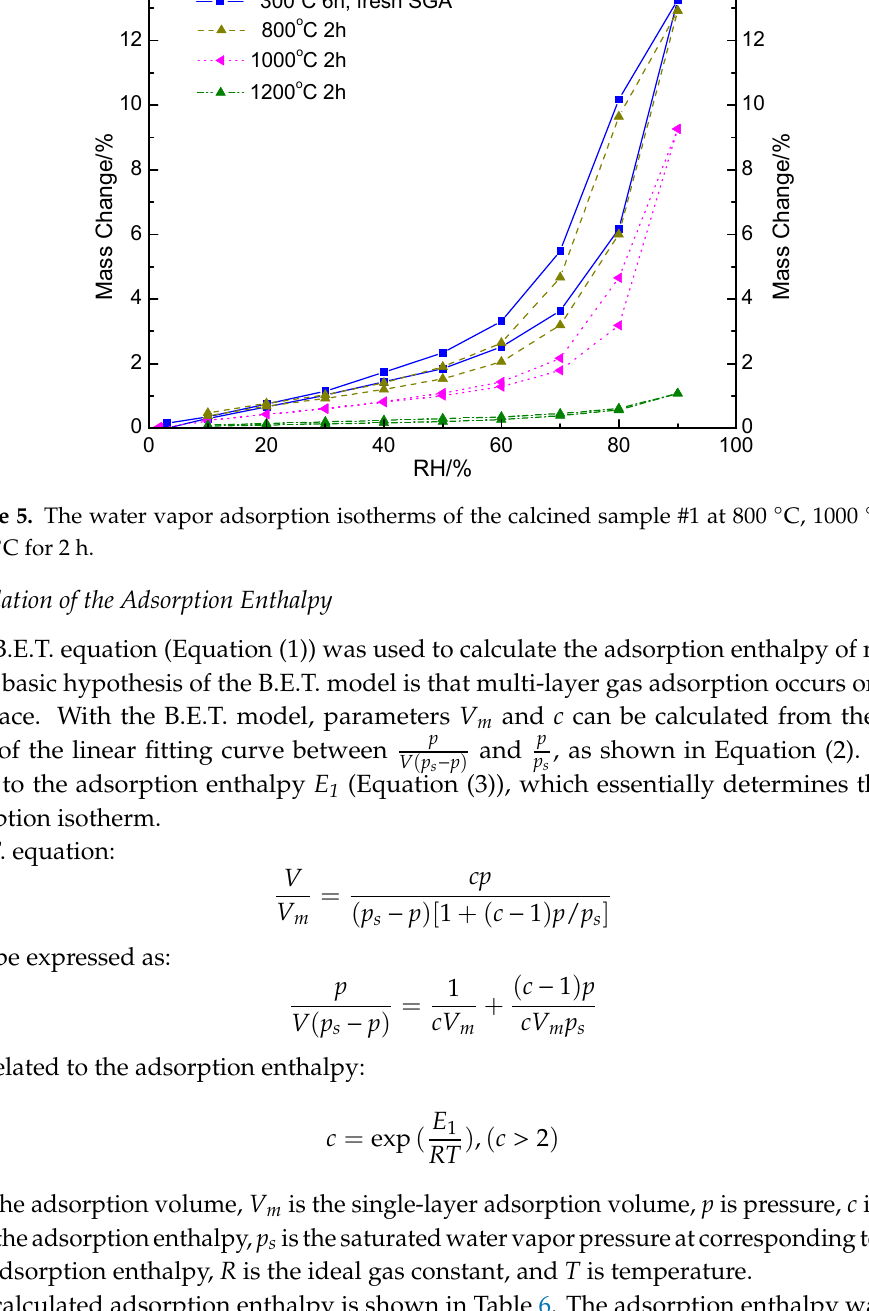
Table 6. The adsorption enthalpy of moisture on smelter grade alumina (SGA) derived from the B.E.T. model.